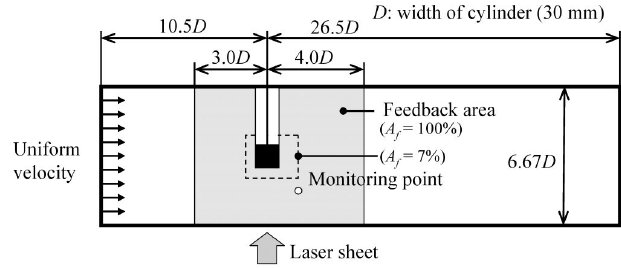
Fig. 2 Two-dimensional computational